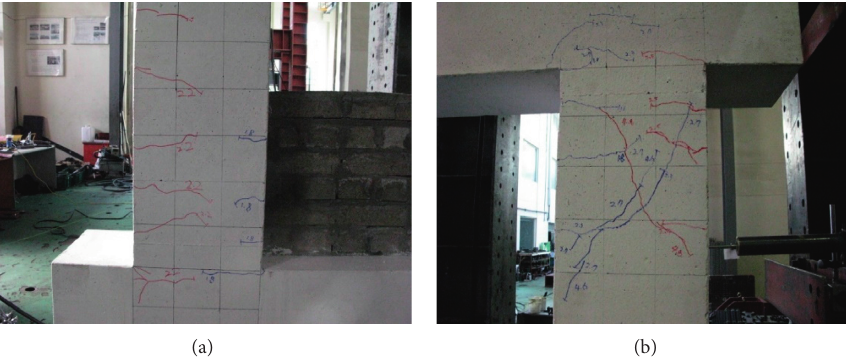
Figure 20: Cracks appeared in the PD-F specimen during pseudodynamic testing under earthquake ground motion of 250gal, after (a) 2.2s with lateral displacement of 7.2 mm and force of –166kN and (b) 4.8 s with lateral displacement of 13.6mm and force of